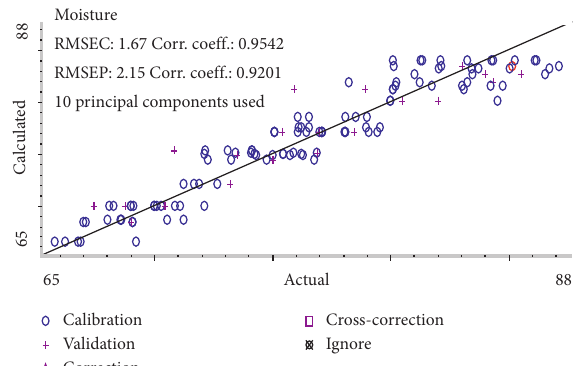
Figure 7: Prediction results of the moisture content